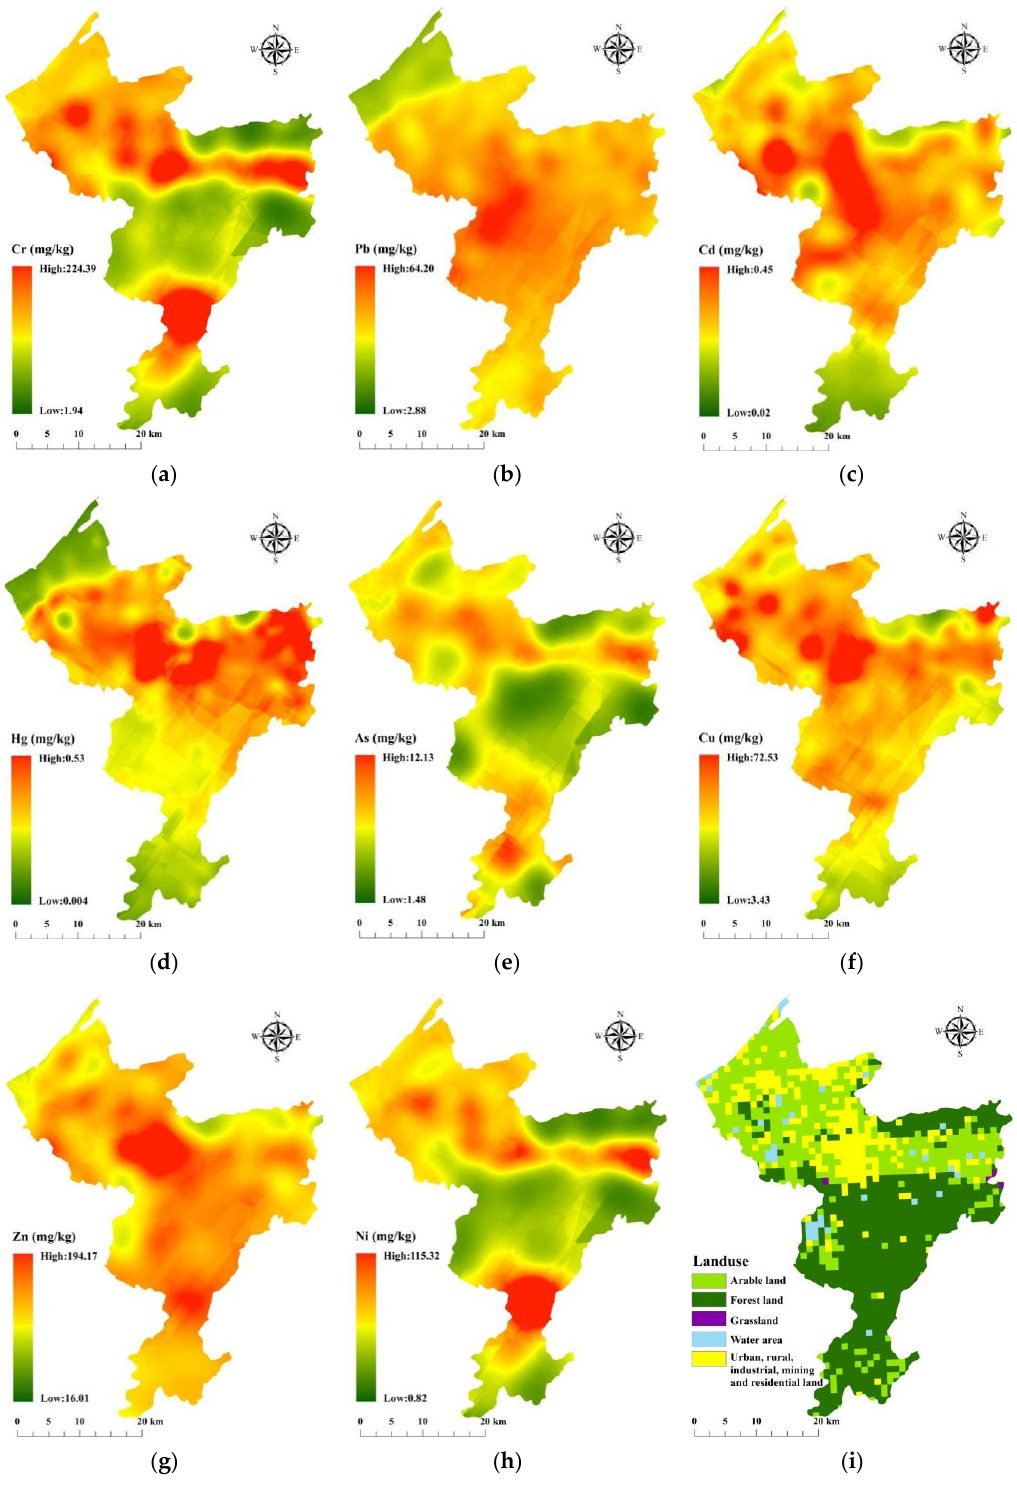
Figure 7. Maps of content of Cr ( a ), Pb ( b ), Cd ( c ), Hg ( d ), As ( e ), Cu ( f ), Zn ( g ), Ni ( h ) and land use types ( i ) in Yuyao City.